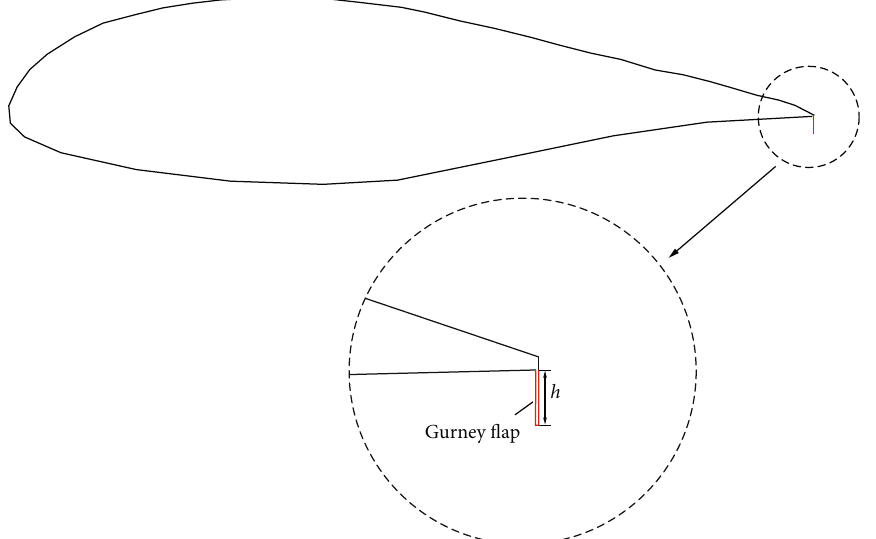
Figure 1: Gurney fl ap on tiltrotor wing section.